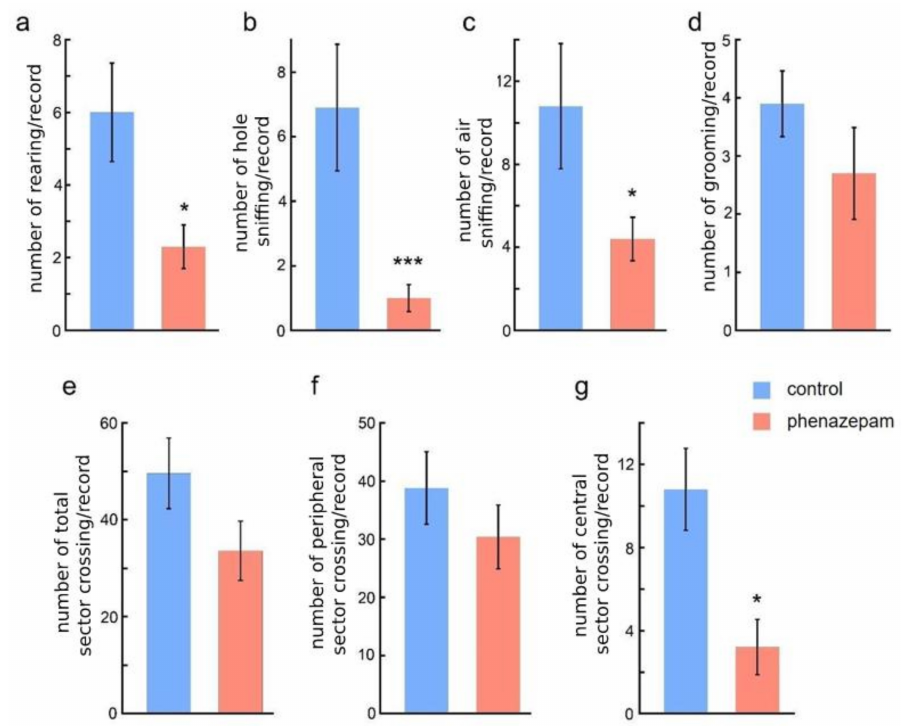
Figure 1. Effect of phenazepam on some rat behavior parameters in the open field test. Averaged exploratory behaviors ( a – c ), self-grooming ( d ) and locomotor activity ( e , f ) in the control (blue bars) and phenazepam (red bars) groups. ( a ) Averaged number of rearing with or without support on the wall of the field. ( b ) Number of arena hole sniffing episodes. ( c ) Air sniffing episodes. ( d ) Short or long grooming. ( e ) Overall crossing of arena sectors. ( f ) Only peripheral sector crossing. ( g ) Only central sector crossing. Units of measurement are number of episodes per record. t -test: *— p < 0.05; ***— p < 0.001; otherwise, not